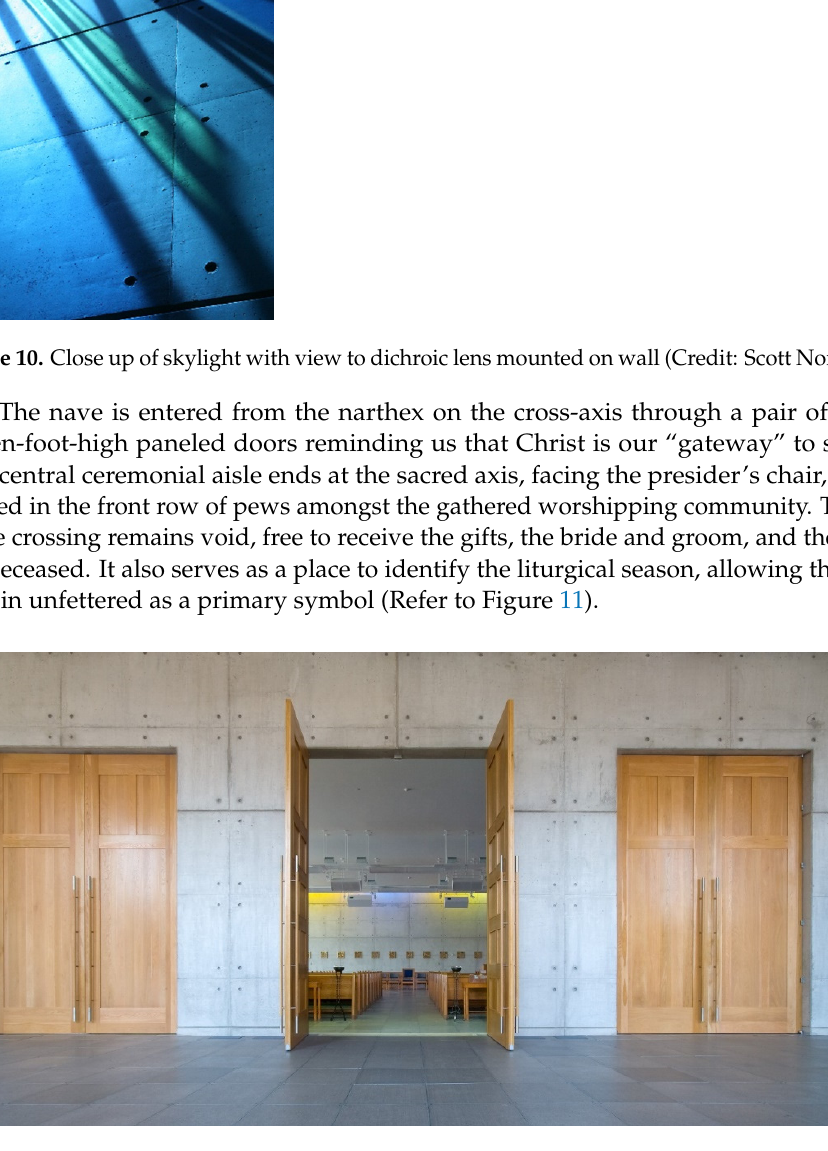
Figure 11. Main doors from the narthex to the worship space along ceremonial axis terminating with the presider’s chair (Credit: Steven Evans). the presider’s chair (Credit: Steven